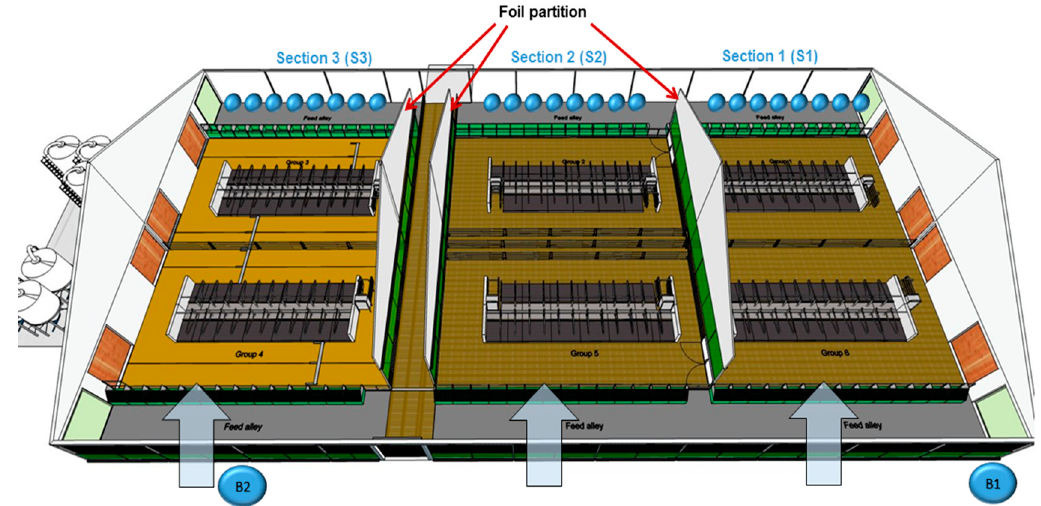
Figure 1. Top view of the barn (68 m × 34 m) showing the three different sections with the